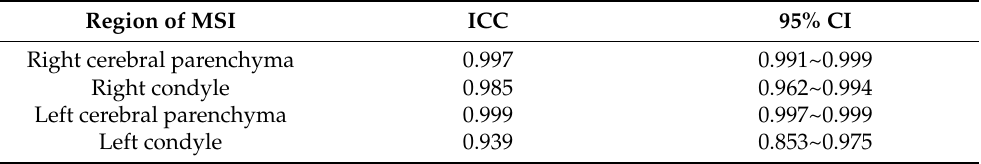
Table 1. Consistency between the surgeon and the radiologist.